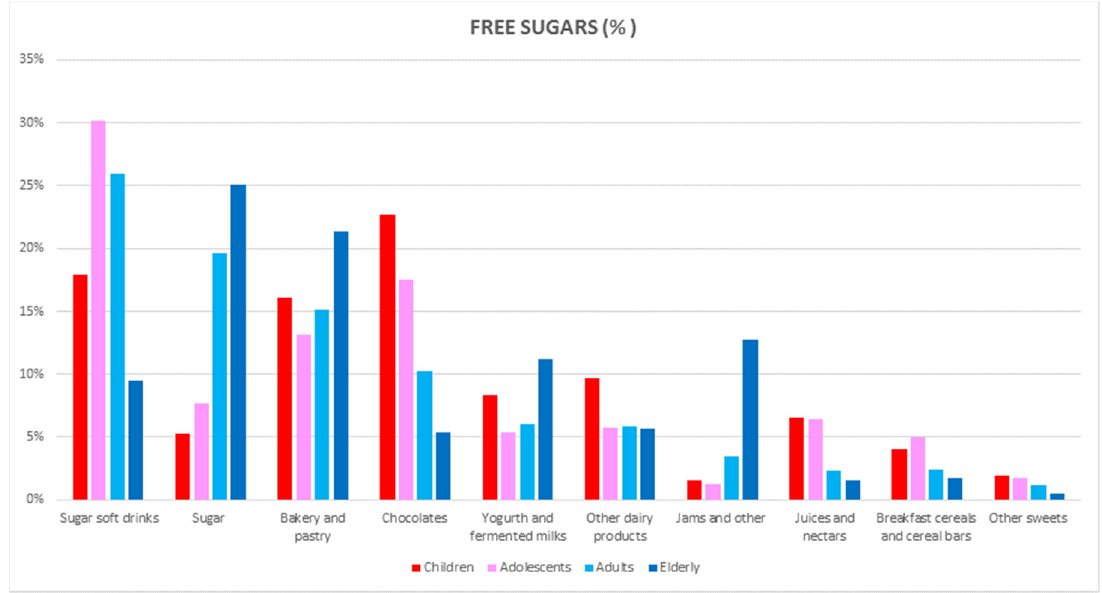
Figure 2. Dietary top 10 food and beverages groups for free sugars (%) by age group in the ANIBES Study.